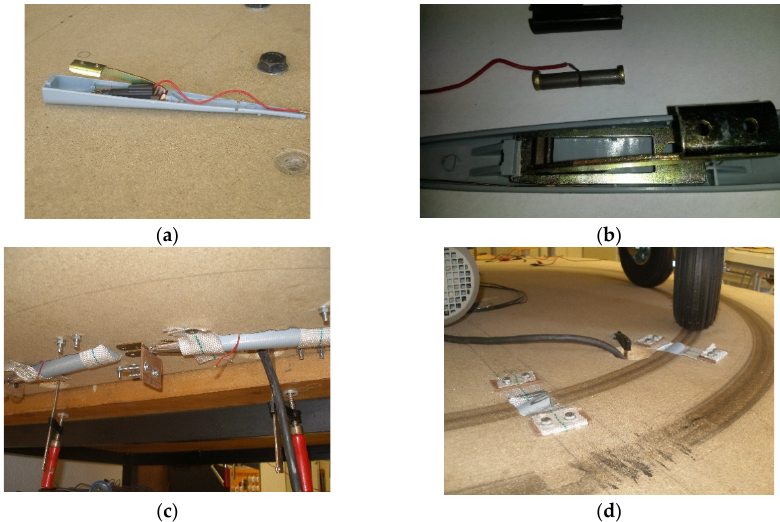
Figure 7. ( a ) Open view of the commercial piezoelectric housing; ( b ) exploded view of the commercial piezoelectric showing the lever mechanical amplifier and the piezoelectric material outside the holder; ( c ) bottom view of the commercial piezoelectric placement in the test bench; ( d ) top view of the PDUTs in the inner path of the road tra ffi c